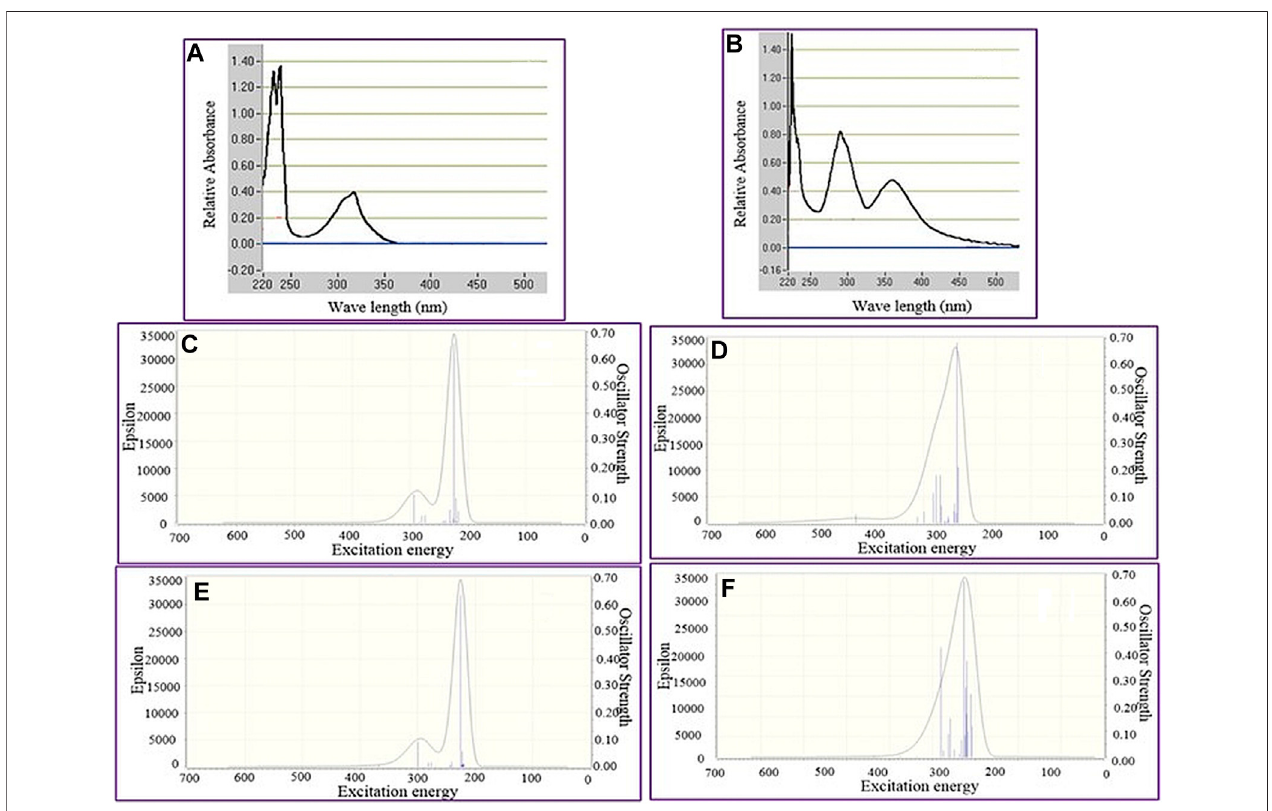
FIGURE 6 | AIM analysis of the epi-CD-X complex. RDG isosurface maps: (A) PH 2 CN – OH as a representative X-epi-CD1 (X: PH 2 CN, OH: O 36 H 37 at C 17 ) and (B) PH